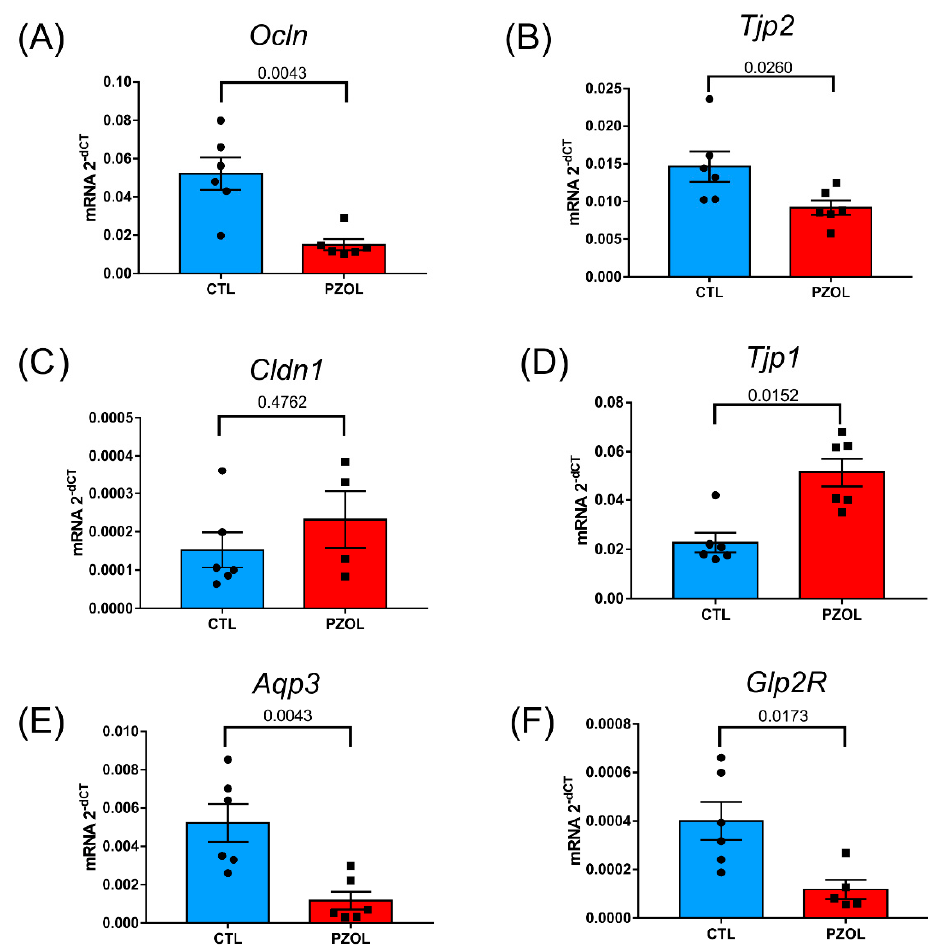
Figure 6. Pantoprazole induced alterations in mRNA of proteins from the epithelial barrier in ileum. mRNA levels of tight junction proteins ( A ) occludin (CTL: n = 6 and PZOL: n = 6), ( B ) ZO-2 (CTL: n = 4 and PZOL: n = 4), ( C ) claudin (CTL: n = 6 and PZOL: n = 4), ( D ) ZO-1 (CTL: n = 6 and PZOL: n = 6), ( E ) aquaporin 3 (CTL: n = 6 and PZOL: n = 6), ( F ) GLP2R (CTL: n = 6 and PZOL: n = 5). Mean ± standard deviation and t -test statistical